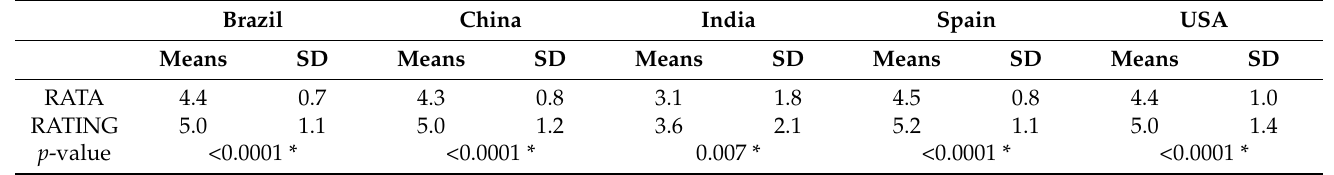
Table 7. Means and standard deviations † p -values for just-about-right ratings for RATA and RATING per